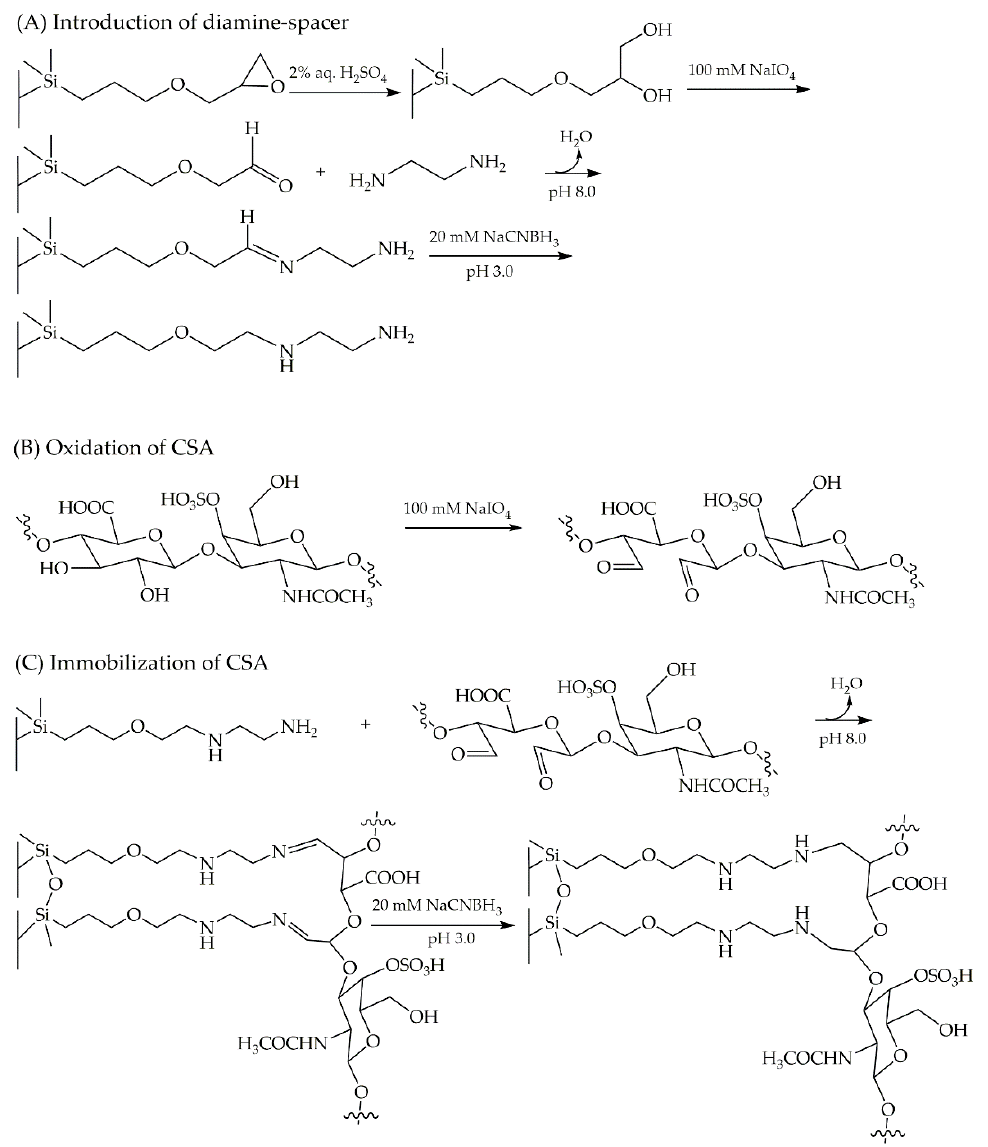
Figure 5. Schematic immobilization of CSA onto the monolithic epoxy column. Introduction of diamine-spacer ( A ), oxidation of chondroitin sulfate A (CSA) ( B ), and immobilization of CSA ( C